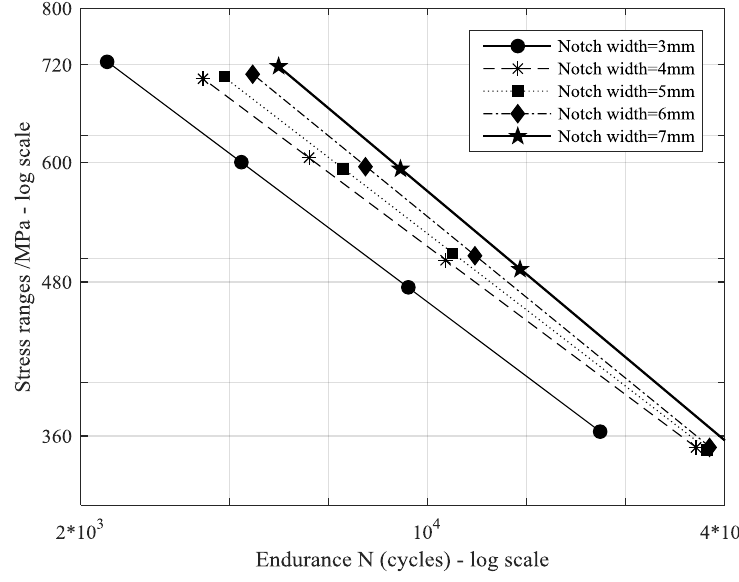
Figure 18. Logarithmic S-N curve of steel wire with notch of different width.